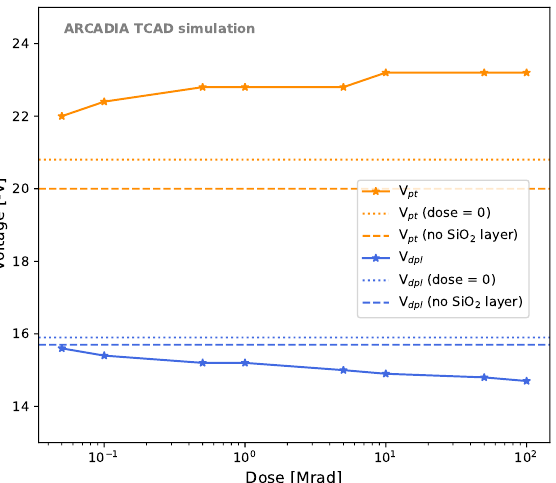
Figure 13. Depletion voltage V dpl (blue) and punch-through voltage V pt (orange) as a function of the total ionizing dose for a 50 µ m thick microstrip sensor. The values obtained in simulations with and without the silicon dioxide layer in the absence of irradiation are shown as horizontal